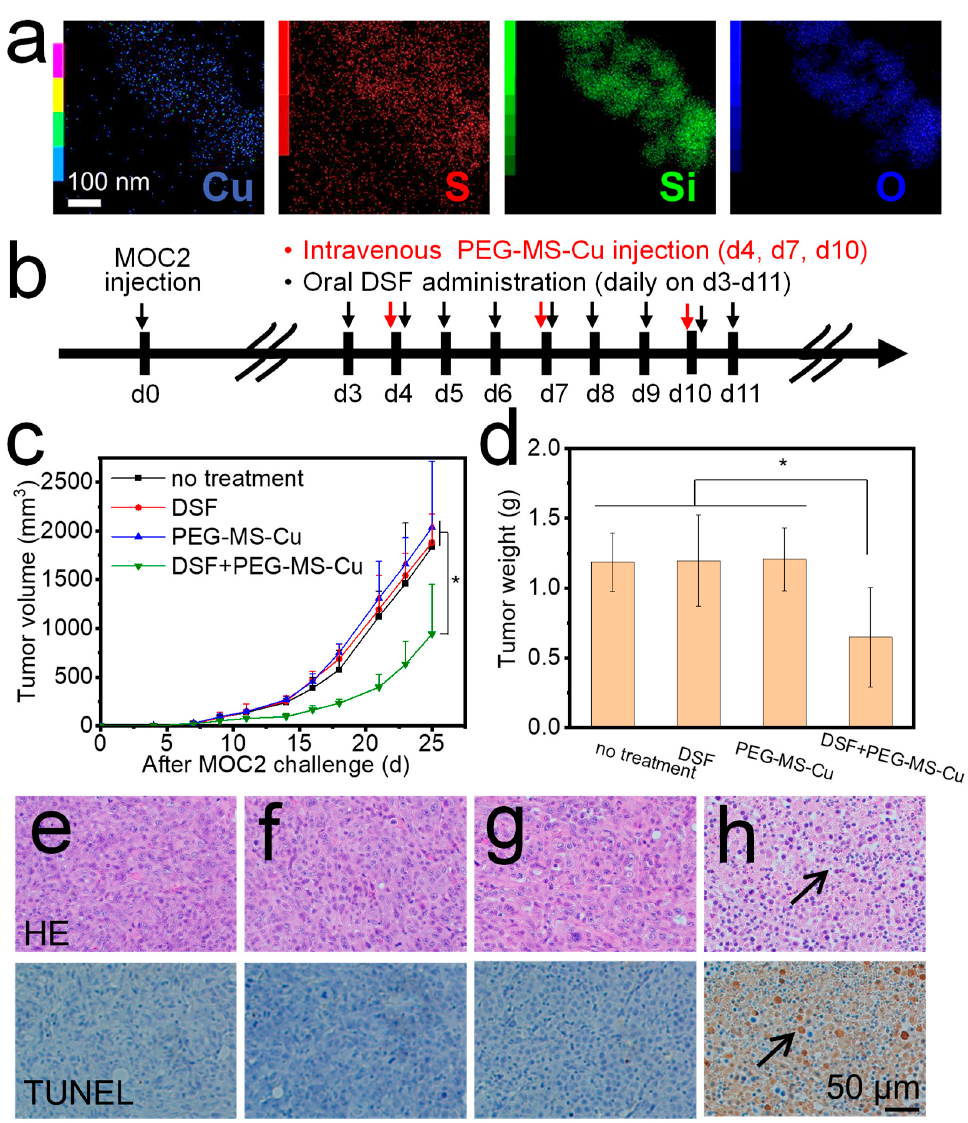
Figure 4. Combination of oral administration of DSF and intravenous administration of PEG-MS-Cu nanospheres inhibited MOC2 cell growth in vivo. STEM-EDX images of PEG-MS-Cu nanospheres ( a ). In vivo antitumor efficacy of combined oral administration of DSF and intravenous administration of PEG-MS-Cu nanospheres. Experimental protocol ( b ), tumor volume ( c ), and tumor weight at the endpoint ( d ). HE and TUNEL staining of tumor with no treatment ( e ), after only oral administration of DSF ( f ), only intravenous administration of PEG-MS-Cu nanospheres ( g ), and combined oral administration of DSF and intravenous administration of PEG-MS-Cu nanospheres ( h ) (*, p < 0.05). Mice without any treatment, with the only oral administration of DSF and with the only intravenous administration of PEG-MS-Cu nanospheres, showed rapid MOC2 growth; tumor volumes reached over 1800 mm 3 and weight reached over 1.1 g on d25 (Figure